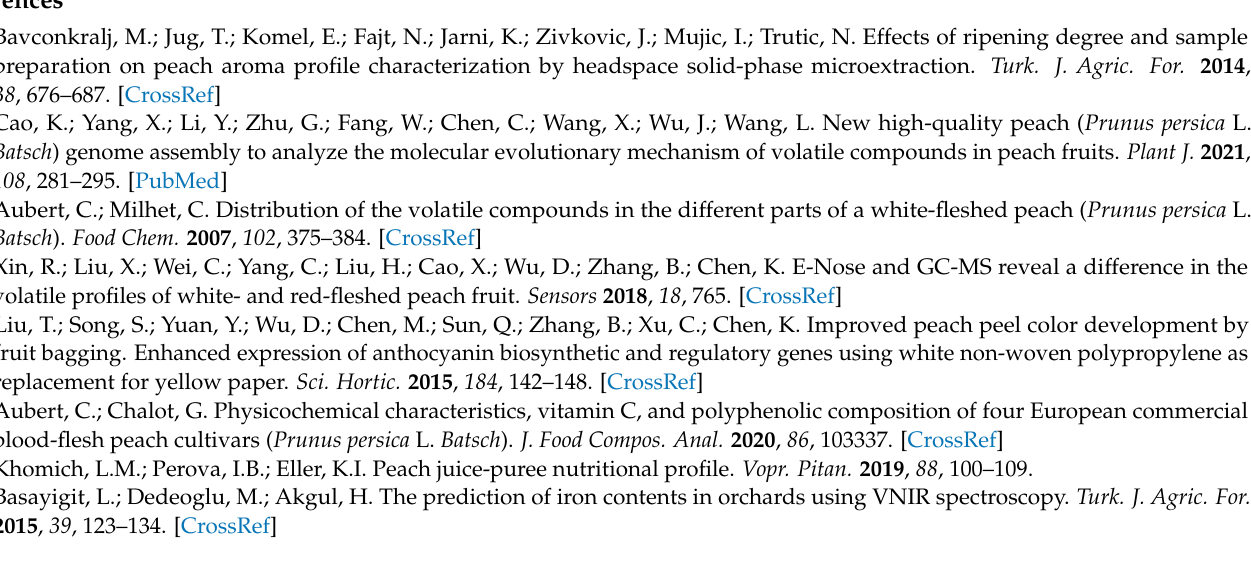
Figure S2: The relative concentration of organic acid in seven peach cultivars; Figure S3: The relative concentration of phenolic compound in seven peach cultivars; Figure S4: The antioxidant capacities in seven peach cultivars; Figure S5: The loading diagram of aroma compounds in seven peach cultivars; Figure S6: The ion chromatograms of the seven peach